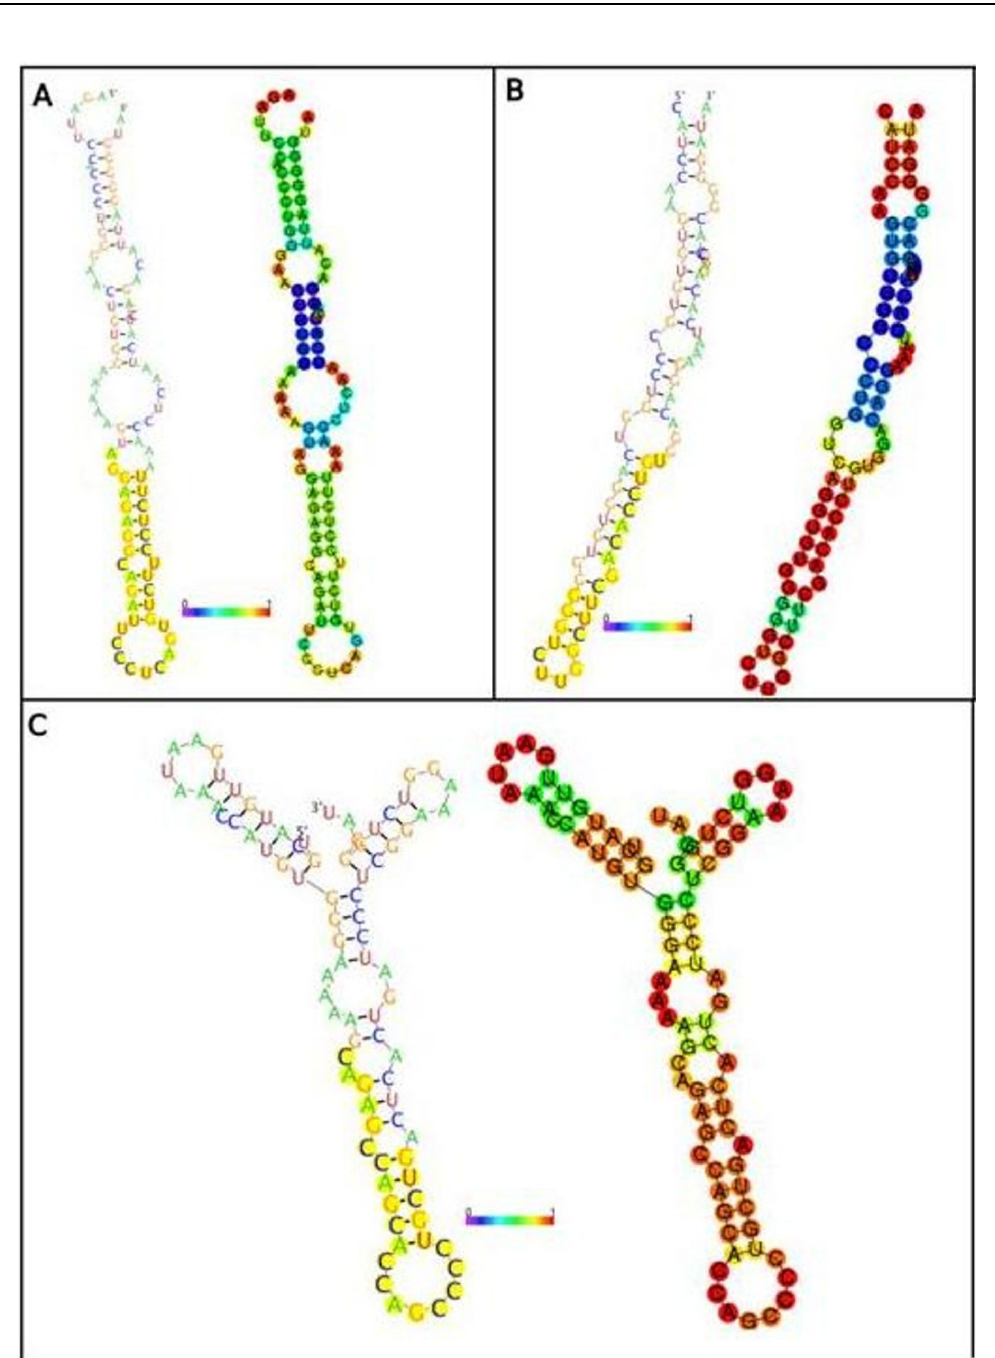
Figure 3 – Secondary structures of the miRNAs. A: miRNA hsa-miR-3916. B: miRNA hsa-miR-3934. C: miRNA hsa-miR-4763-5p. The yellow region shows the mature miRNA and the likelihood of them being associated with the BTD gene. The red color corresponds to the highest correlation between free energy binding between miRNA: mRNA and its